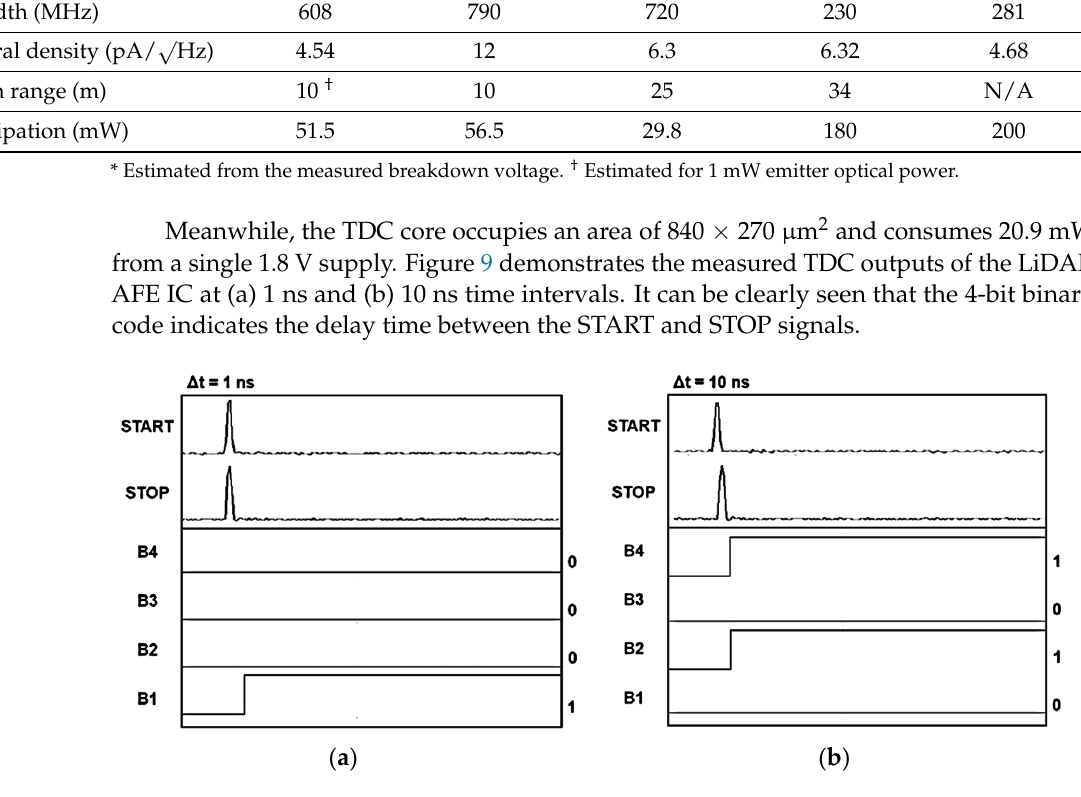
Table 1. Performance Comparison of the Proposed LiDAR AFE IC with Other Prior Arts.